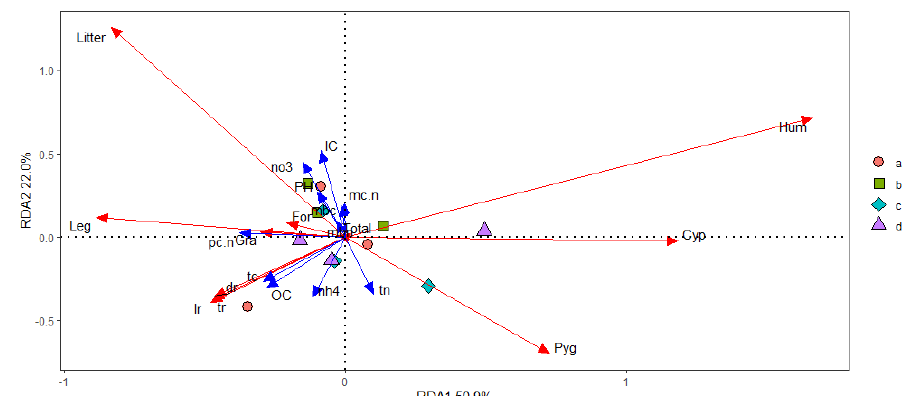
Figure 13. Reduction dimension analysis of in soil−plant−microbial system. Notation: “a” denoted GKH (3.75 ± 0.75 sheep/ha), “b” denoted KH (7.25 ± 0.25 sheep/ha), “c” denoted KPT (8.50 ± 0.35 sheep/ha), and “d” denonted KPC (11.75 ± 0.95 sheep/ha). Concentrations of soil microbial C(mbc), concentrations of soil microbial N (mbn), soil total C (TC), soil organic C (OC), soil inorganic C (IC), soil total N (TN), soil NH 4+ -N (nh4) and NO 3− -N (no3), soil pH (pH), stoichiometry of soil microbial total C to total N (mc.n), plant community total C to total N aboveground (pc.n), soil organic C to soil total N (sc.n), soil total C to soil total N(tn.tc), dead root tissue (dr), living root tissue (lr), total root tissue(tr), biomass of Gramineae (Gra), biomass of Cyperaceae (Cyp), biomass of Leguminosae (Leg), biomass of Forb (For), biomass of K. humilis (Hum), biomass of K. pygmaea , biomass of the litter aboveground.